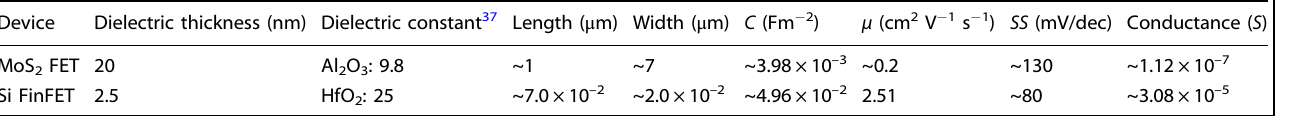
Table 1. Transistor parameters of the p-type Si FinFET and n-type MoS 2 FET combined in CMOS inverter.